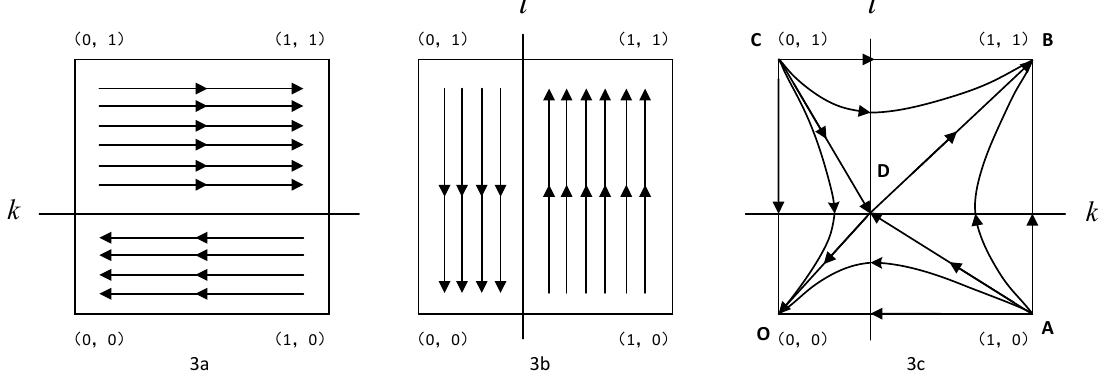
Figure 3. Analysis of the evolution process in Case 1. ( a ) Power grid companies; ( b ) users; and ( c ) power grid companies and users.